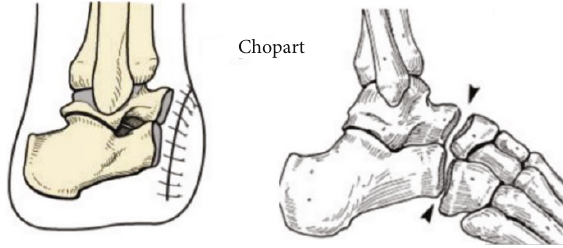
Figure 1: The Chopart amputation [7].